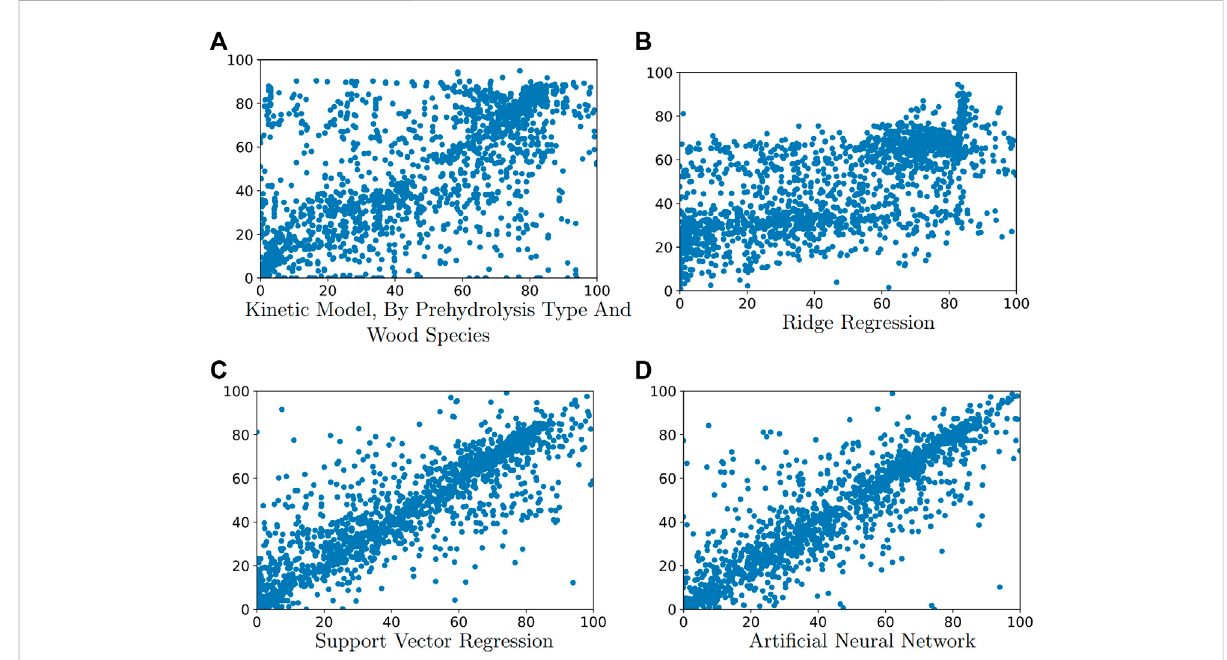
FIGURE 1 Predicted versus actual yield of total soluble xylose for test data for: (A) kinetic model fi t by prehydrolysis type and wood species, (B) ridge regression, (C) support vector regression, and (D) arti fi cial neural network.